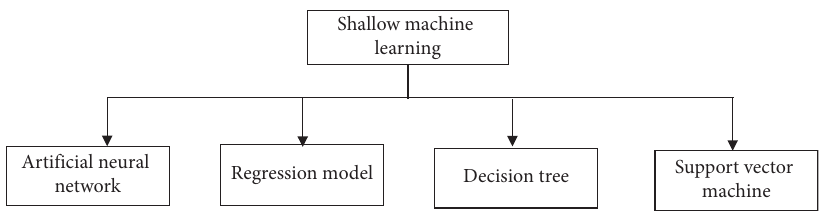
Figure 6: Subdivision of shallow machine learning models.